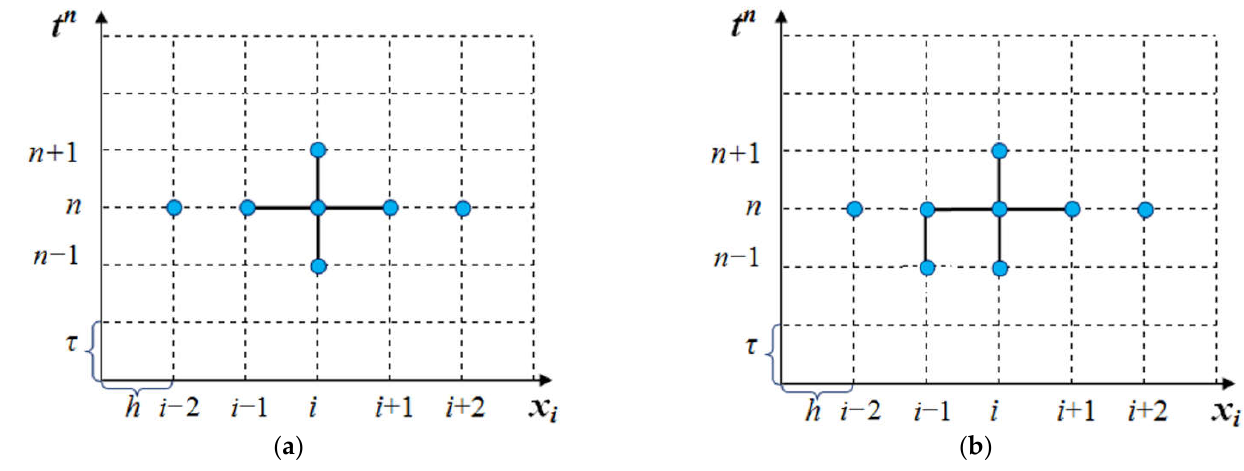
Figure 2. Extended templates of the “Standard Leapfrog” ( a ) scheme and a linear combination of the schemes “Upwind Leapfrog” and “Standard Leapfrog” ( b ) for the KdV equation.